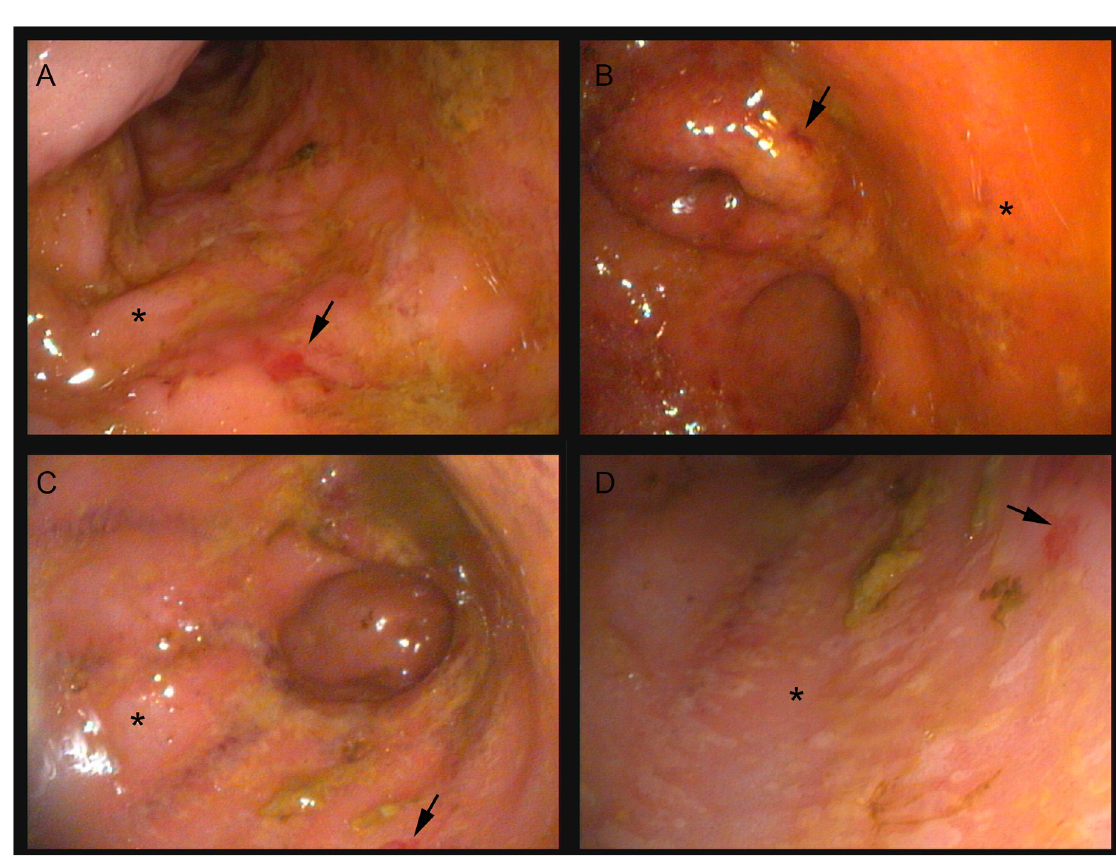
Fig 1. Colonoscopy images, proximal colon, dogs with AHDS. (A & B) Sham-treated control dog. (C & D) Fecal microbiota transplantation-recipient dog. The black arrows indicate areas of ulceration and hemorrhage. The black asterisks indicate dull edematous colonic mucosa. AHDS: acute hemorrhagic diarrhea